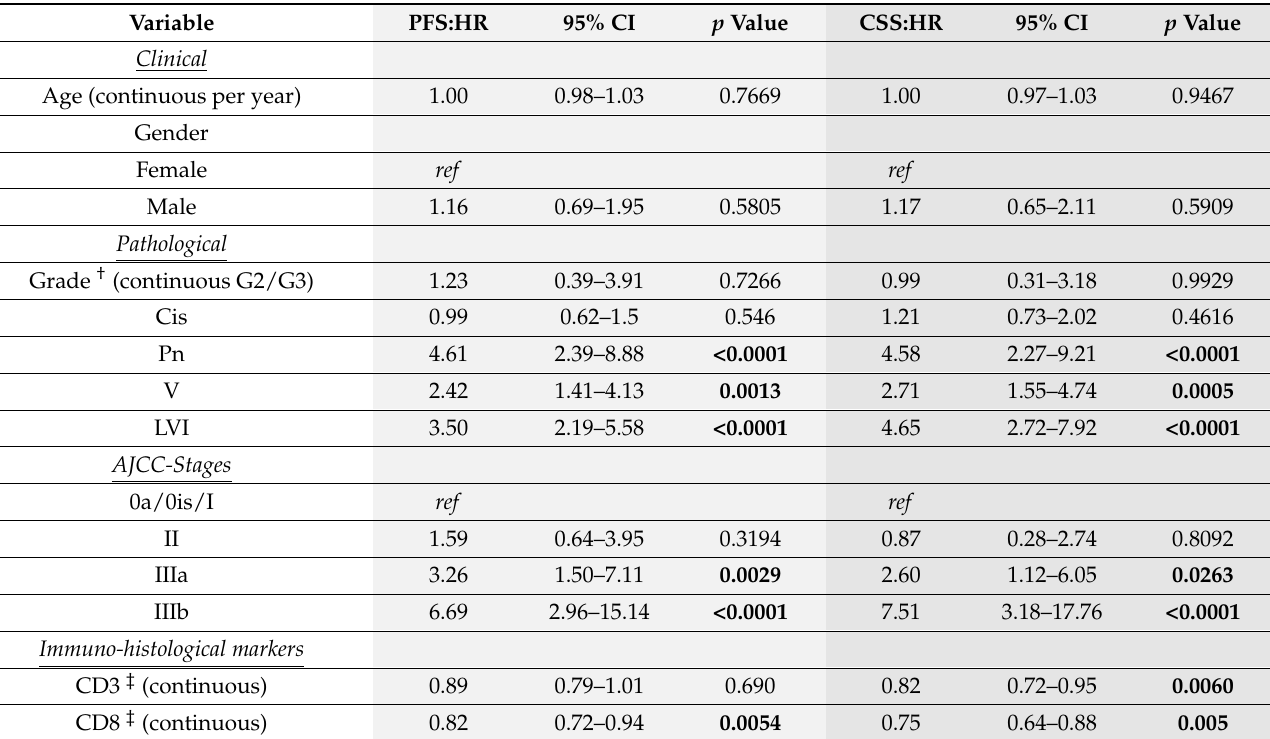
Table 2. Univariable Cox-Regression Analysis.